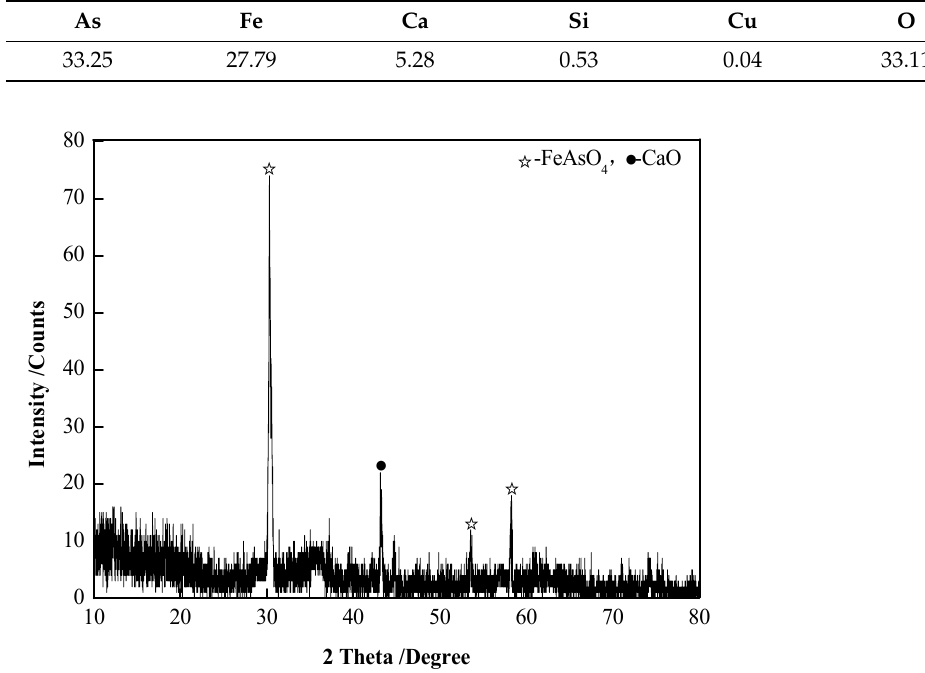
Figure 1. XRD patterns of the arsenic–iron precipitate.